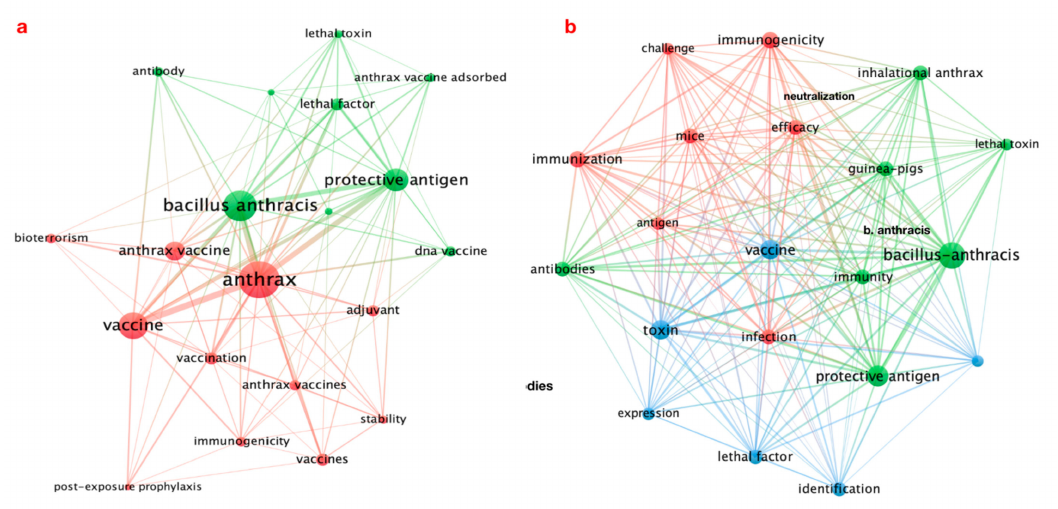
Figure 7. ( a ) Author’s keyword, ( b ) KeyWords Plus network visualization